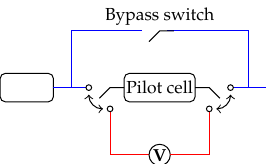
Figure 3. Semi-pilot cell disconnection during open-circuit voltage measurement.